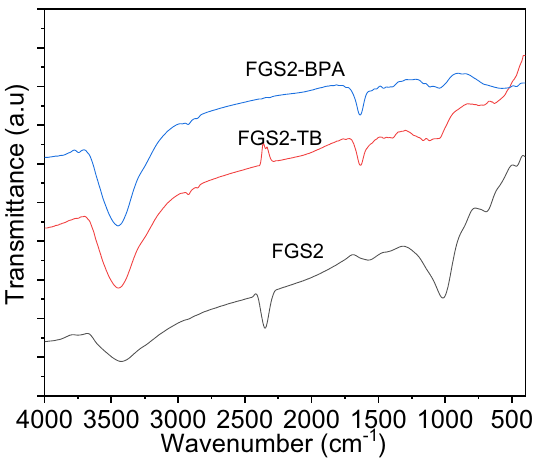
Figure 14. FTIR spectra before and after adsorption of BPA and TB onto